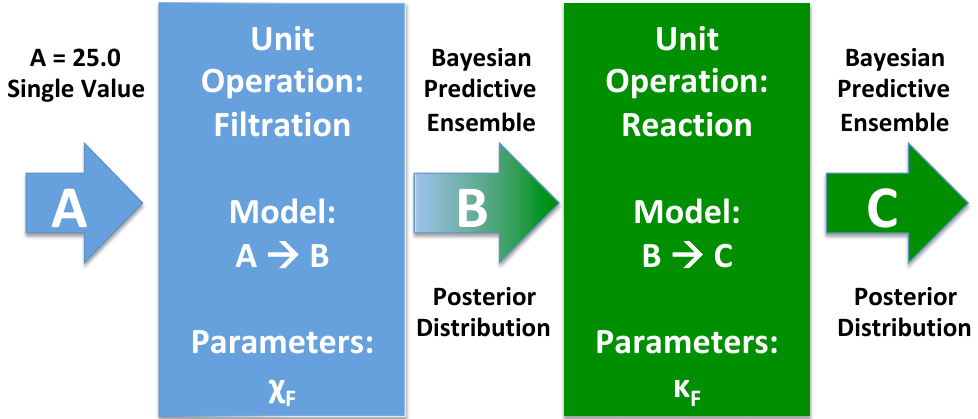
Figure 2. Schematic representation of the coupled unit operations in terms of a Bayesian network [40]: (i) filtering and (ii) chemical reaction. The models predict the concentration B from a fixed value of the concentration A = 25.0 in accordance with Equation (30). From the corresponding posterior distribution of B as calculated by the Bayesian predictive ensemble, 100 values were randomly drawn, which were then used for the calculation of C in accordance with Equation (31). The species B react to species C with a certain time constant κ F